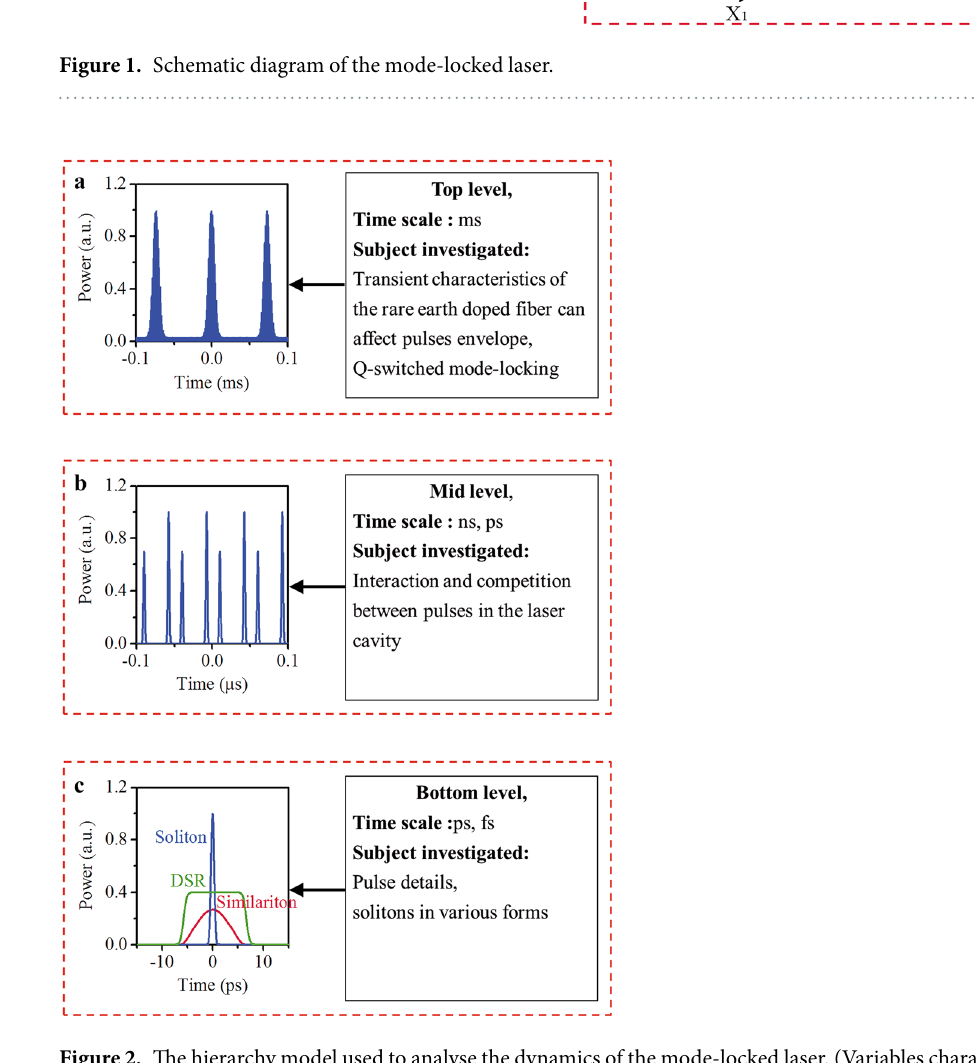
Figure 2. The hierarchy model used to analyse the dynamics of the mode-locked laser. (Variables characterizing the system dynamics are arranged by temporal